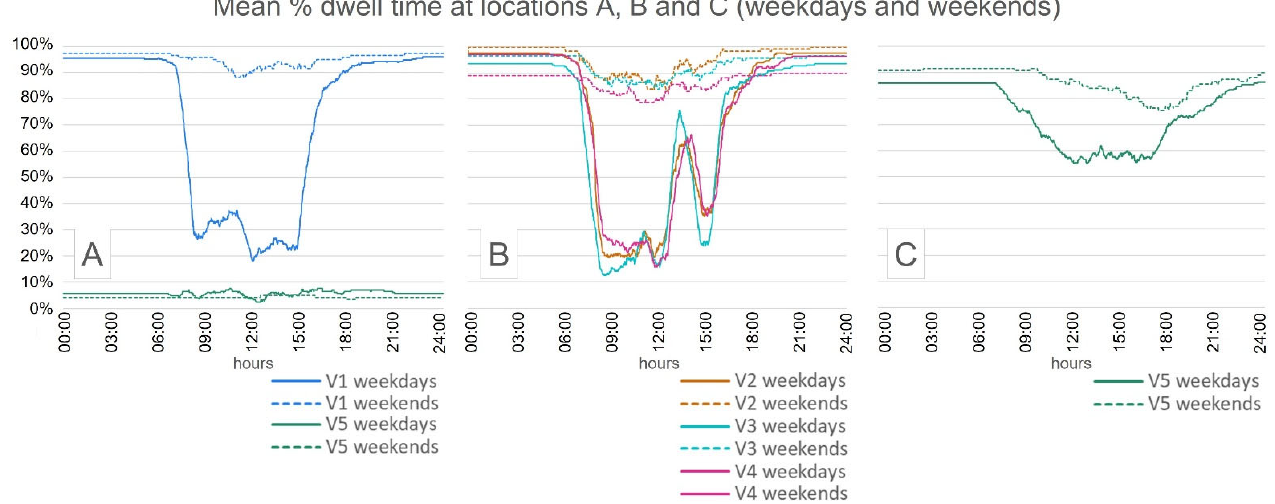
Figure 7. Average 24 h dwelling profile at locations A, B, and C per vehicle (V). 100% means that the vehicle was at that location all year.